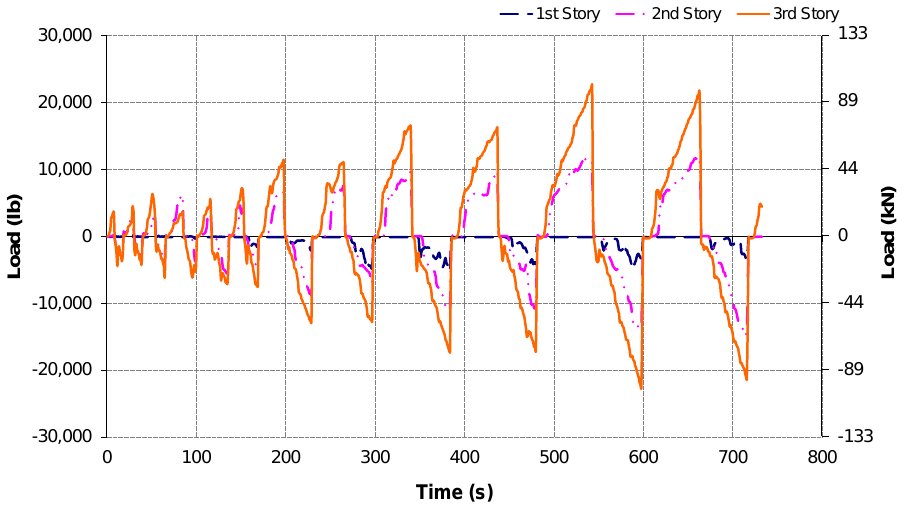
Figure 19. Full brace cyclic test FBCT4 load